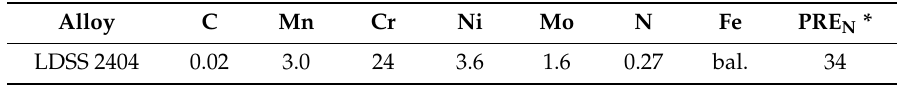
Table 1. Nominal chemical composition (wt.%) and pitting resistance equivalent number (PRE N ) value of lean duplex stainless steel (LDSS)